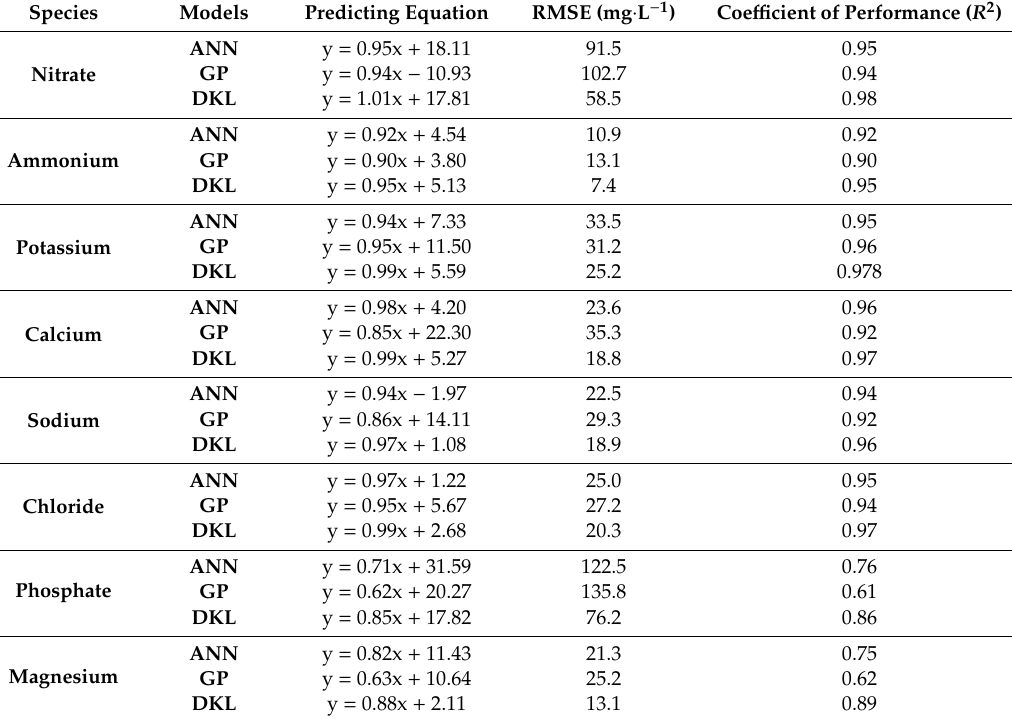
Table 7. The correlation of the predicted concentrations (y) with the actual values (x). Species Models Predicting Equation